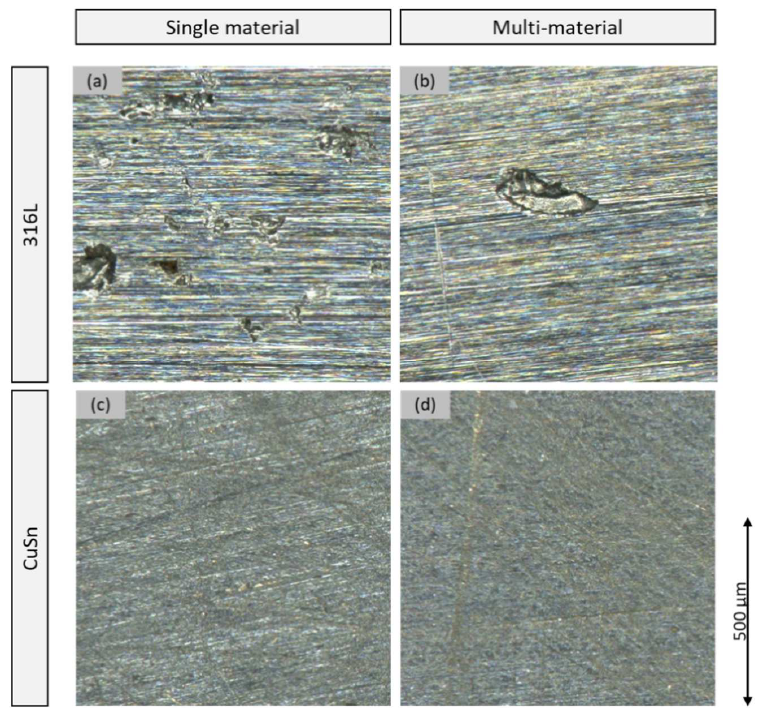
Figure 8. Surfaces after the LSV test under the light microscope ( a ) 316L-AM-A; ( b ) 316L/CuSn-AM steel side; ( c ) CuSn-AM-A; ( d ) 316L/CuSn-AM bronze side